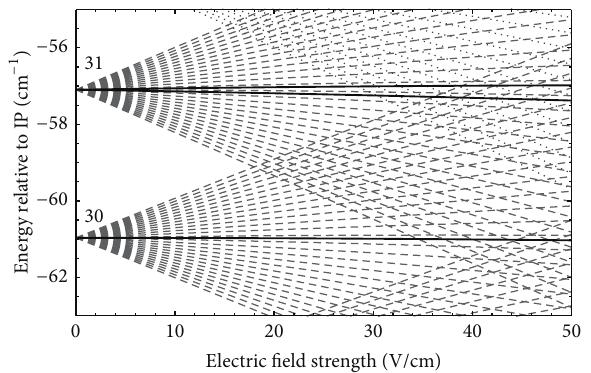
Figure 11: Stark states of 𝑛 = 30 and 31 states of Ps, with 𝑚 = 2 (grey dashed) and 𝑚 = 29 (black). In the 𝑛 = 30 level, the 𝑚 = 29 state is a circular state and experiences no first-order Stark shift and only a very weak second-order shift, as explained in the